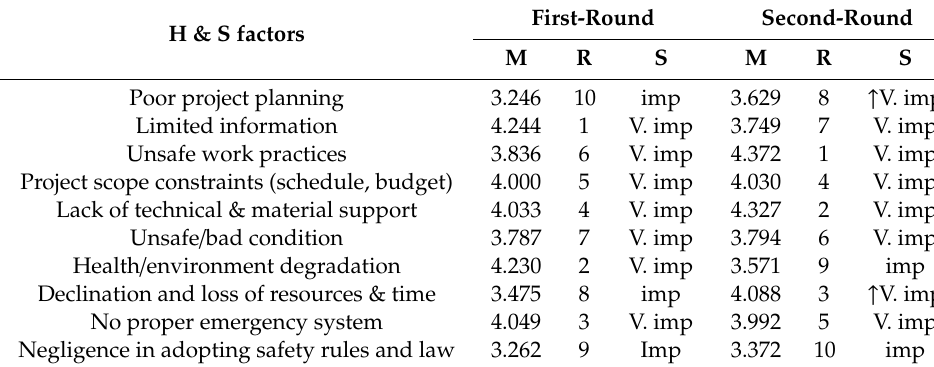
Table 6. The significance level of health and safety